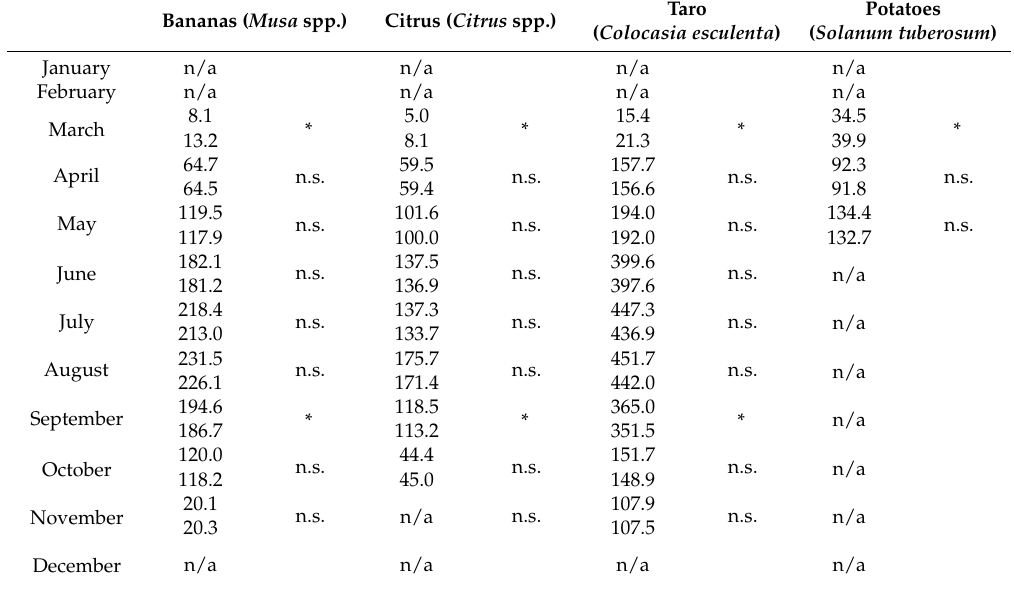
Table 3. Net irrigation requirements (NIR) values in mm of the most water-consuming crops in Cyprus. The upper number for each month indicates the average value for the 1976–2000 period and the lower number the average value for the period 1990–2014. Non-significant differences between these two averages are indicated by n.s. (paired t -test) and significant differences ( p < 0.05) by *. Months that are not included in the irrigation period of a crop are indicated by n/a